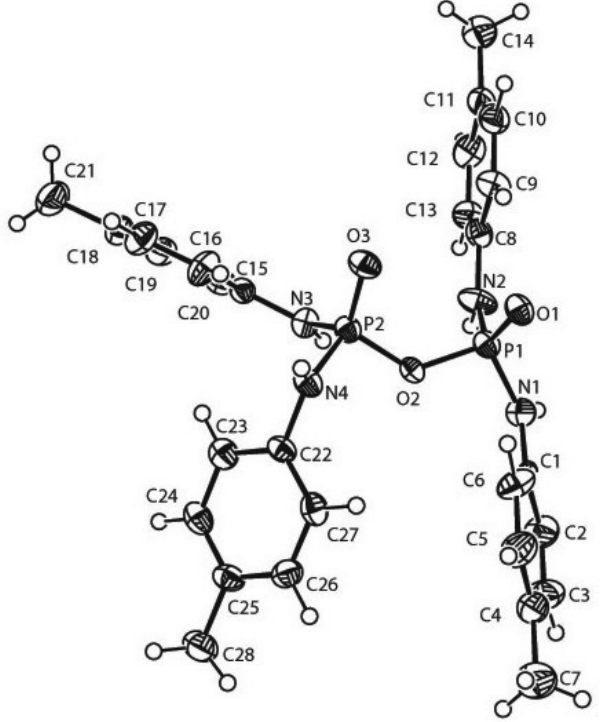
Table 1. Data collection and handling.